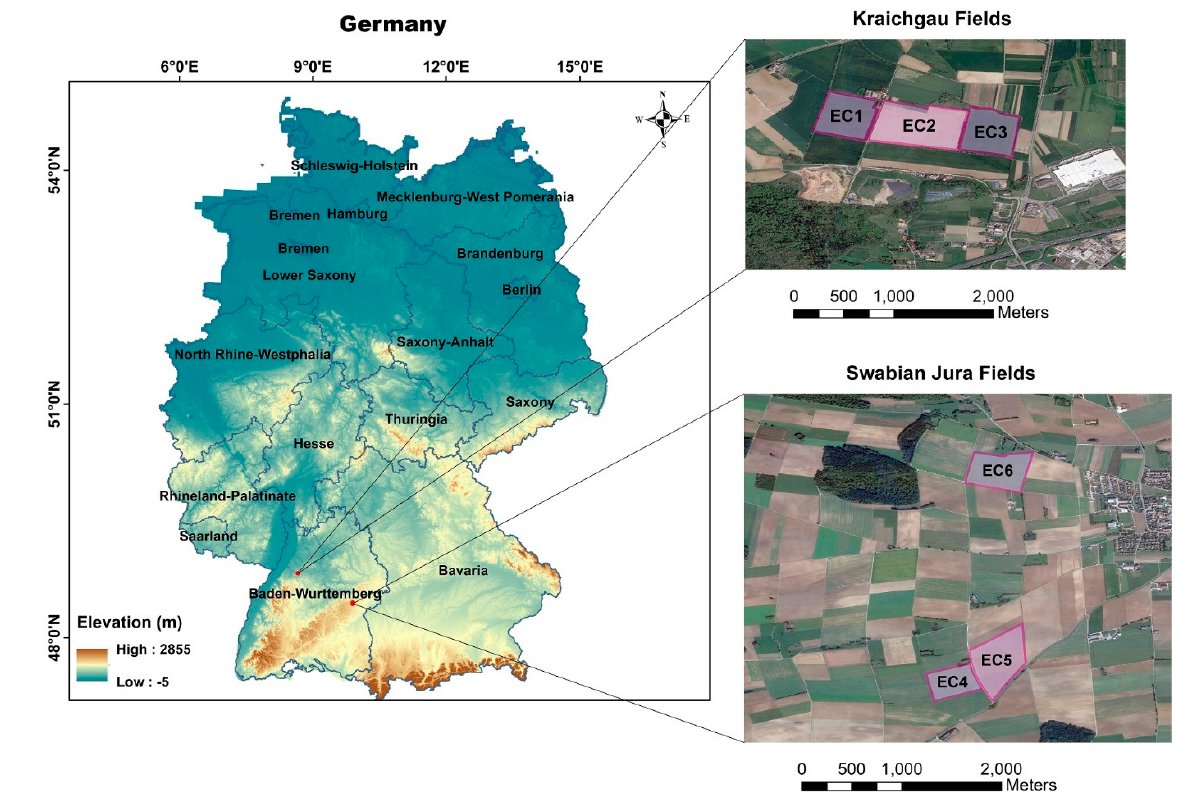
Figure 1. Geographical location of research fields in the Kraichgau and Swabian Jura regions, Germany [39]. Table 1. Information on winter wheat ( Triticum aestivum ) cultivars (CUL), sowing dates (SD) and harvest dates (HD) for the studied site-years. The empty cells denote periods when other crops were